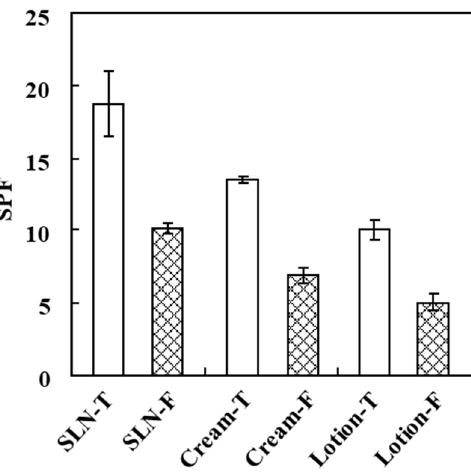
Figure 6. The SPF analysis of SLM, cream, and lotion. The left bar shows the SPF value of each formula, including the three types of sunscreen chemicals, ethylhexyl methoxycinnamate, bis-ethylhexyphenol methoxyphenol triazine, and ethylhexyl salicylate with fucoxanthin. The right bar shows the SPF value of each formula including only the three types of sunscreen chemicals.